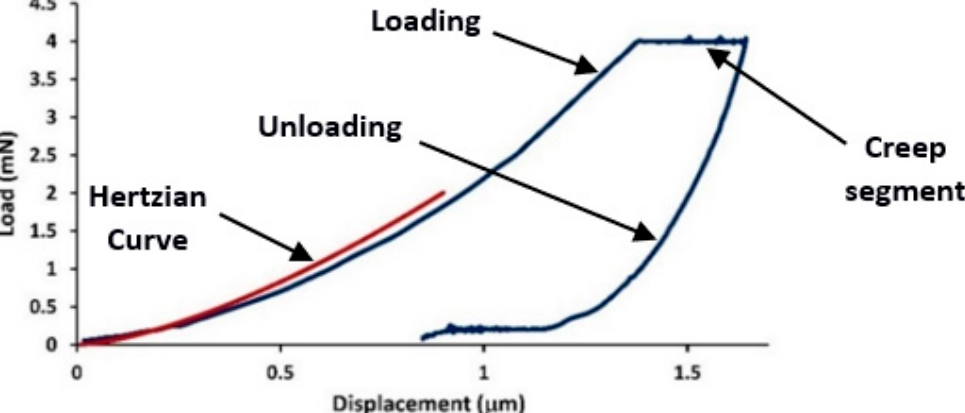
Figure 2. Representative nanoindentation curve, indicating indentation load in terms of indentation depth obtained by the load–hold–unload–hold nanoindentation test on HDPE. Elastic response according to Hertzian elastic contact theory (red line) [32] and experimental nanoindentation curve (blue line) for a load of 4 mN and loading rate of 25 μ N/s.